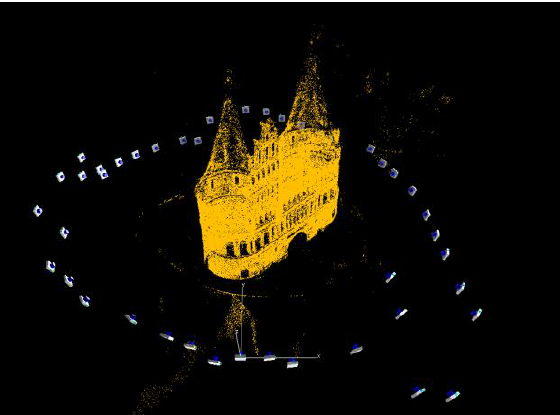
Figure 3. Configuration for 225,000-point Holstentor